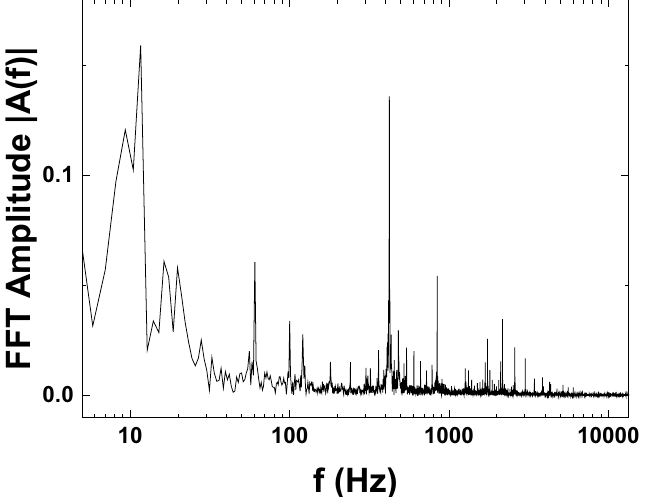
Figure 3. Amplitude of the Fourier transform of the time-resolved intensity emitted from the sample. Continuous low-frequency contributions arise due to mechanical noise, while discrete contributions appearing at multiples of 60 Hz are a consequence of the pulse-width modulation scheme used by the spatial light